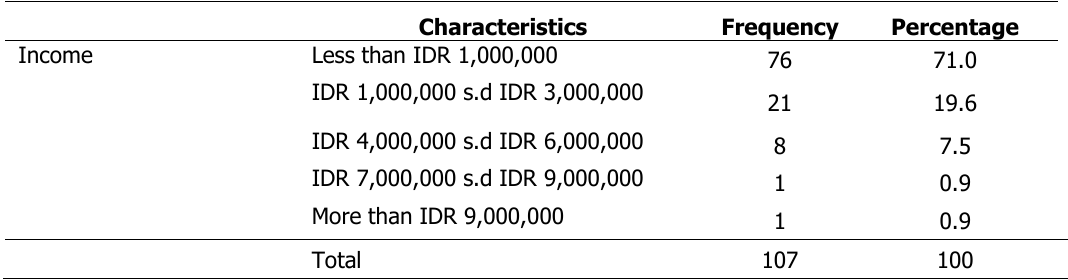
Table 4. Demographic Characteristics of Observations Based on Income